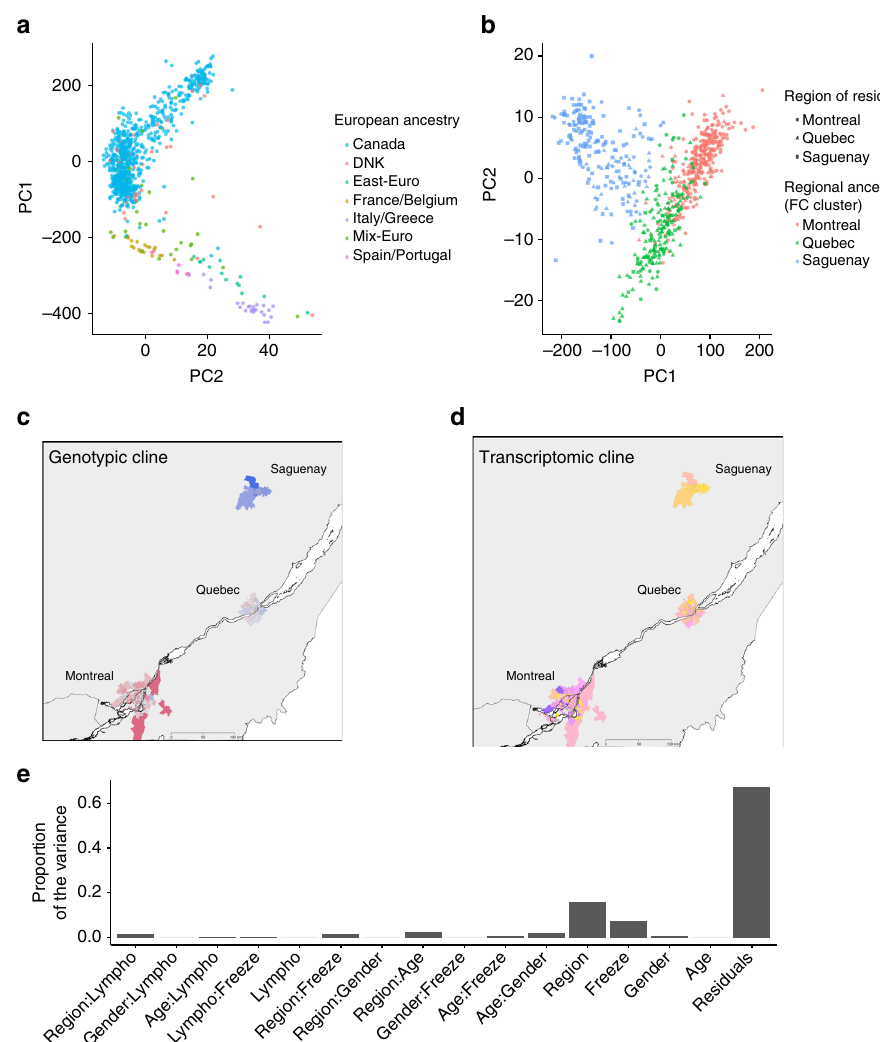
Fig. 1 Genetic and transcriptomic variation within the CARTaGENE cohort sample. a Principal component analysis (PCA) of individuals of European descent, including FCs ( n = 887). Individuals are labeled according to self-declared ancestry based on the origin of four grandparents. b PCA on the haplotype chunk 61 count matrix of French-Canadians ( n = 689) reveals three groups corresponding the region of residence, with SAG individuals showing less overlap with either of MTL or QUE individuals, in line with their historical isolation 25, 26 . c Genotypic cline for individuals by location of residence (three-digit postal code) sampled across the province. Color indicate the average value of the fi rst principal component from a PCA on genotypes in each three-digit postal code district level ( n = 157). d Transcriptomic cline for individuals by location of residence sampled across the province. Colors represent the average value of the fi rst principal component from a PCA on the transcriptome in each three-digit postal code district level ( n = 189). e Proportion of transcriptomic variance (PVCA) in FCs explained by low-level phenotypes and their